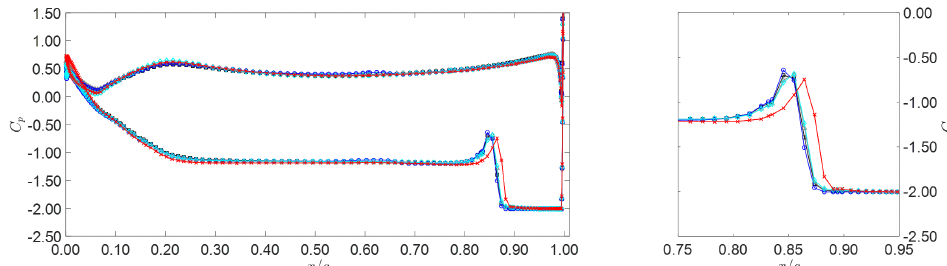
Figure 32. Comparison of pressure coefficient at the radius r / R = 0.7 on the blades. PPTC Case 1 conditions in model- and full-scale. The legend is the same as in Figure